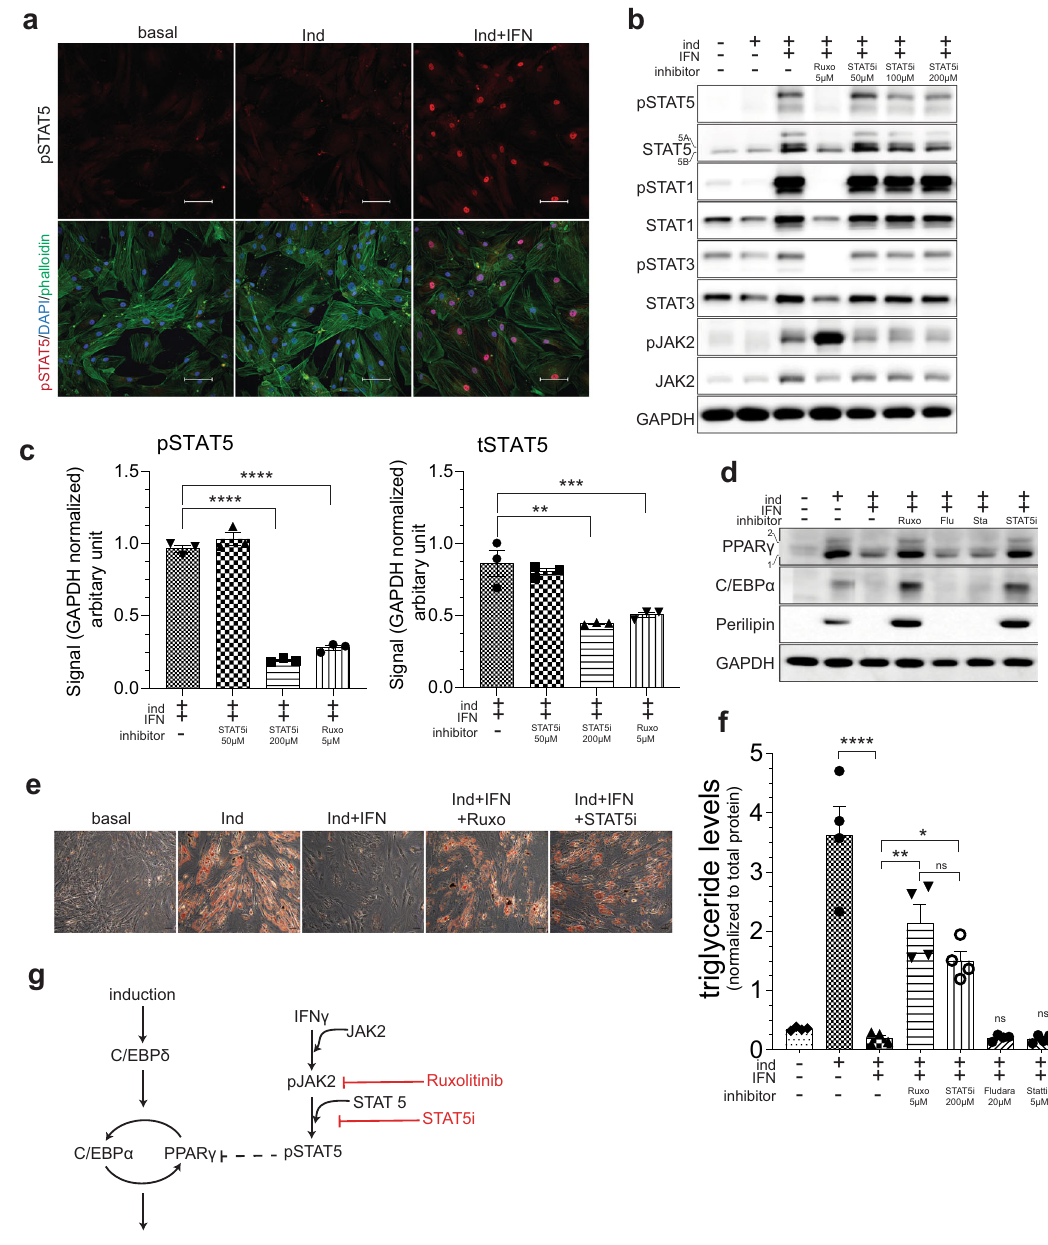
Fig. 3 STAT5 is the major mediator of IFN γ ’ s anti-adipogenic action. a Confocal Z projection of hVA-MSC stained with pSTAT5 antibody after 10 days of adipogenic stimulation with/out IFN γ (10 ng/ml). FITC-Phalloidin (green) and DAPI (blue) were used for marking the cytoskeleton and nucleus, respectively. An image from one representative donor ( N = 3) is shown. b Western blot analysis of hVA-MSCs after 10 days of adipogenic induction with/out human IFN γ (10 ng/ml) along with the inhibitors mentioned. Ruxo-Ruxolitinib. c Quanti fi cation of pSTAT5 and tSTAT5 bands from western blot analysis of hVA-MSCs after 10 days of adipogenic induction with IFN γ (10 ng/ml), STAT5i or Ruxolitinib at the concentrations mentioned; N = 3. d Representative phase-contrast microscopy image of Oil Red-stained hVA-MSCs ( N = 3) after 14 days of adipogenic induction with/out IFN γ (10 ng/ml) with inhibitors mentioned (STAT5i — 200 µM, Ruxolitinib — 5 µM). e Representative western blot analysis ( N = 3) of hVA-MSCs after 10 days of adipogenic induction with/out human IFN γ (10 ng/ml) along with the inhibitors mentioned (STAT5i — 200 µM, Ruxolitinib — 5 µM, Flu — fl udarabine; 20 µM, Sta-stattic; 5 µM). f Colorimetric triglyceride assay of hVA-MSC extract after 14 days of adipogenic induction with/out human IFN γ (10 ng/ml) and inhibitor concentrations as above. Triglyceride levels were normalized to total cellular protein concentration; N = 4. g Schematic diagram representing the effects of IFN γ -activated STAT5 mediated inhibition of adipogenesis. Ind-adipogenic induction. Normal cell culture media- (Ind − IFN − ) treated cells were used as the basal condition. For western blots, GAPDH was used as a loading control. Scale bar: 100 µm. Error bars represent mean ± SEM. * indicates statistical signi fi cance (* P < 0.05; ** P < 0.005; *** P < 0.0005; **** P < 0.00005) of Dunnet ’ s test ( c ) or Tukey ’ s test ( f ) post one-way